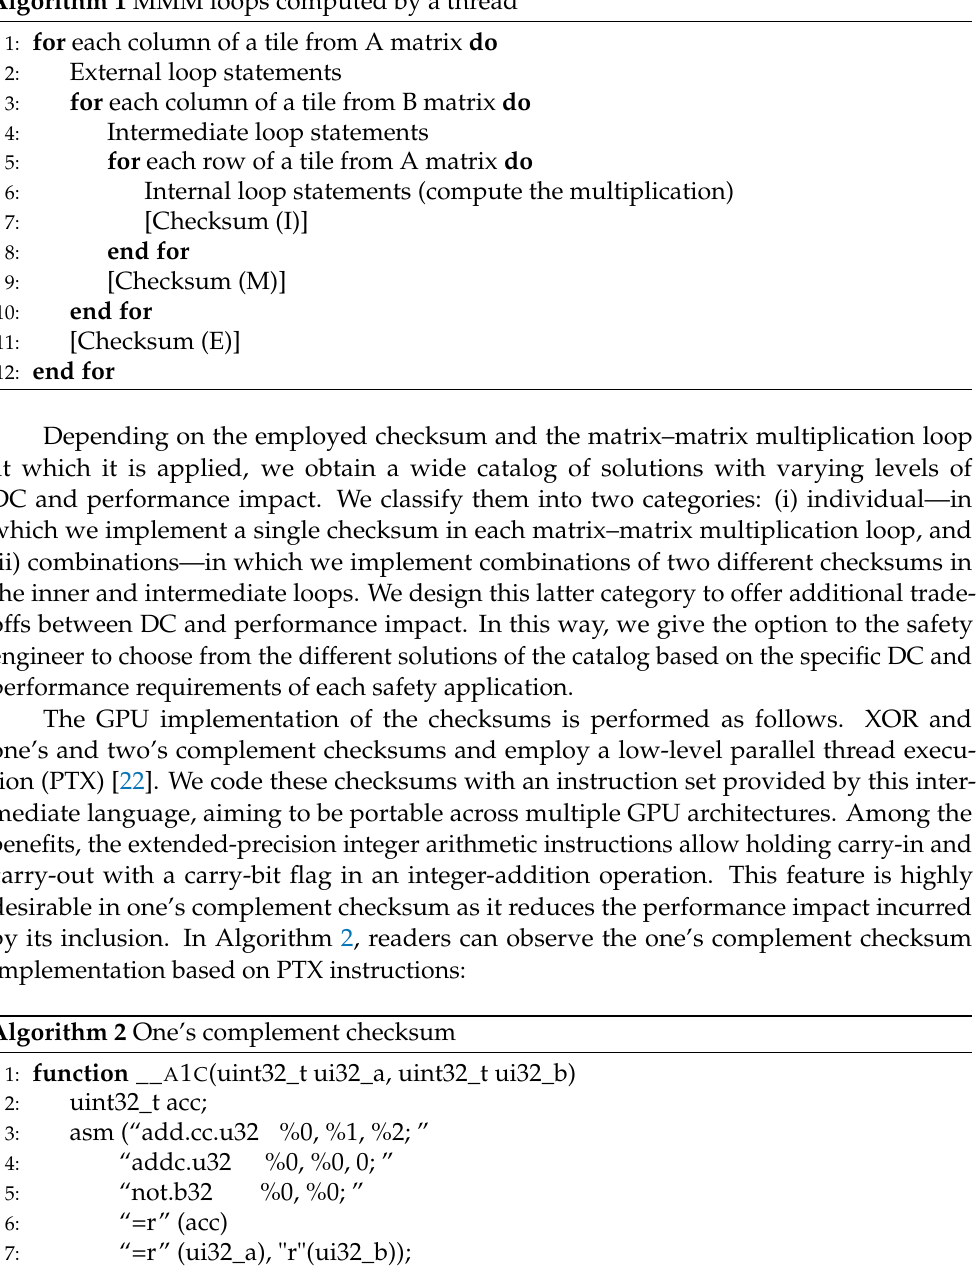
Algorithm 1 MMM loops computed by a thread